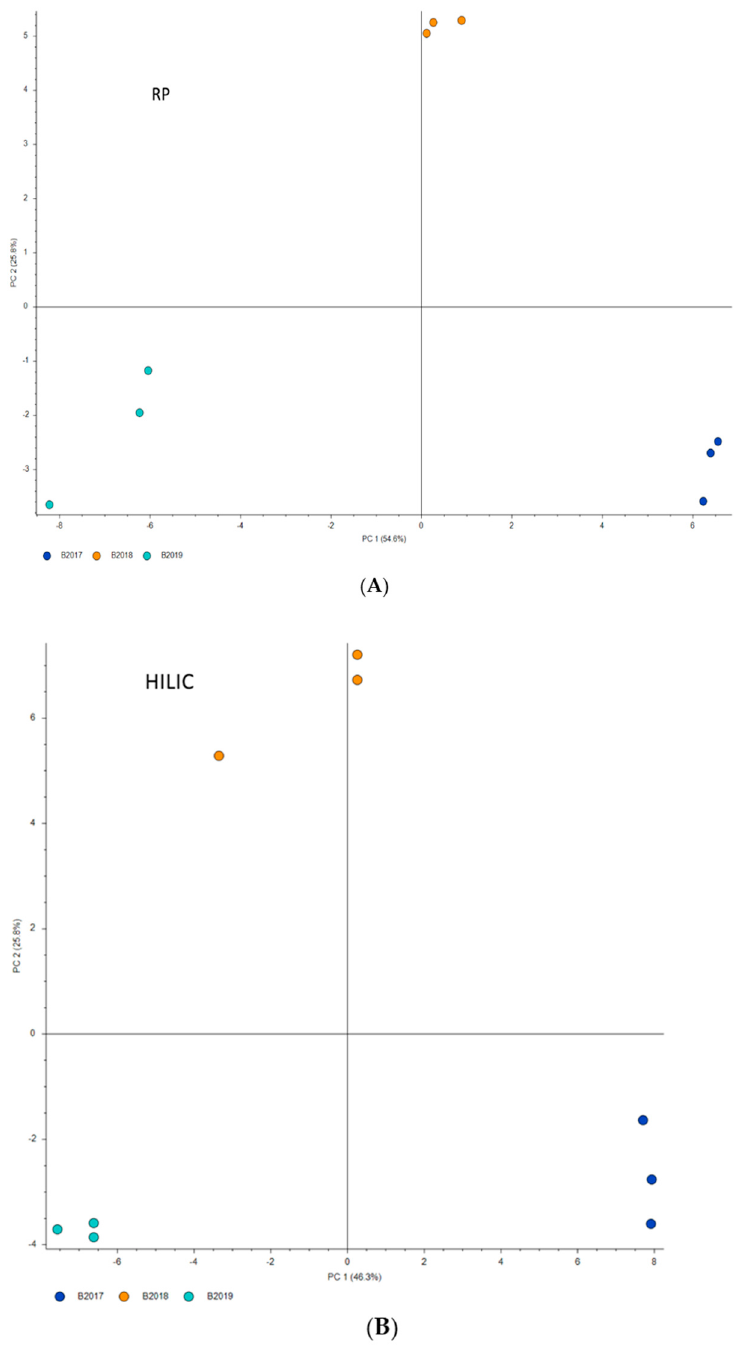
Figure A2. ( A ) Principal component analysis (analyzed in Compound Discoverer) of all identified metabolites in different batches (2017, 2018, 2019, stored at − 80 °C until analyzed) of RP ‐ HRMS data; ( B ) principal component analysis (analyzed in Compound Discoverer) of all identified metabolites in different batches (2017, 2018, 2019, stored at − 80 °C until analyzed) of HILIC ‐ HRMS data.